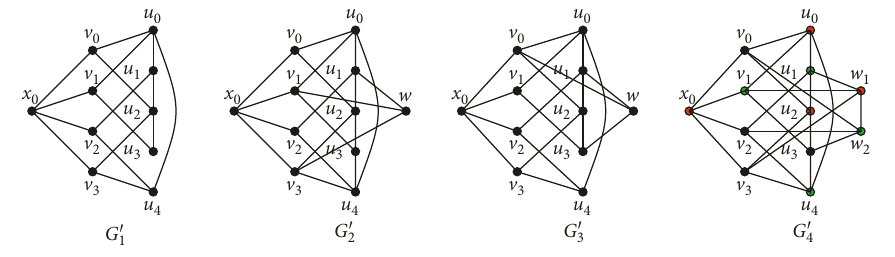
Figure 2: Four graphs